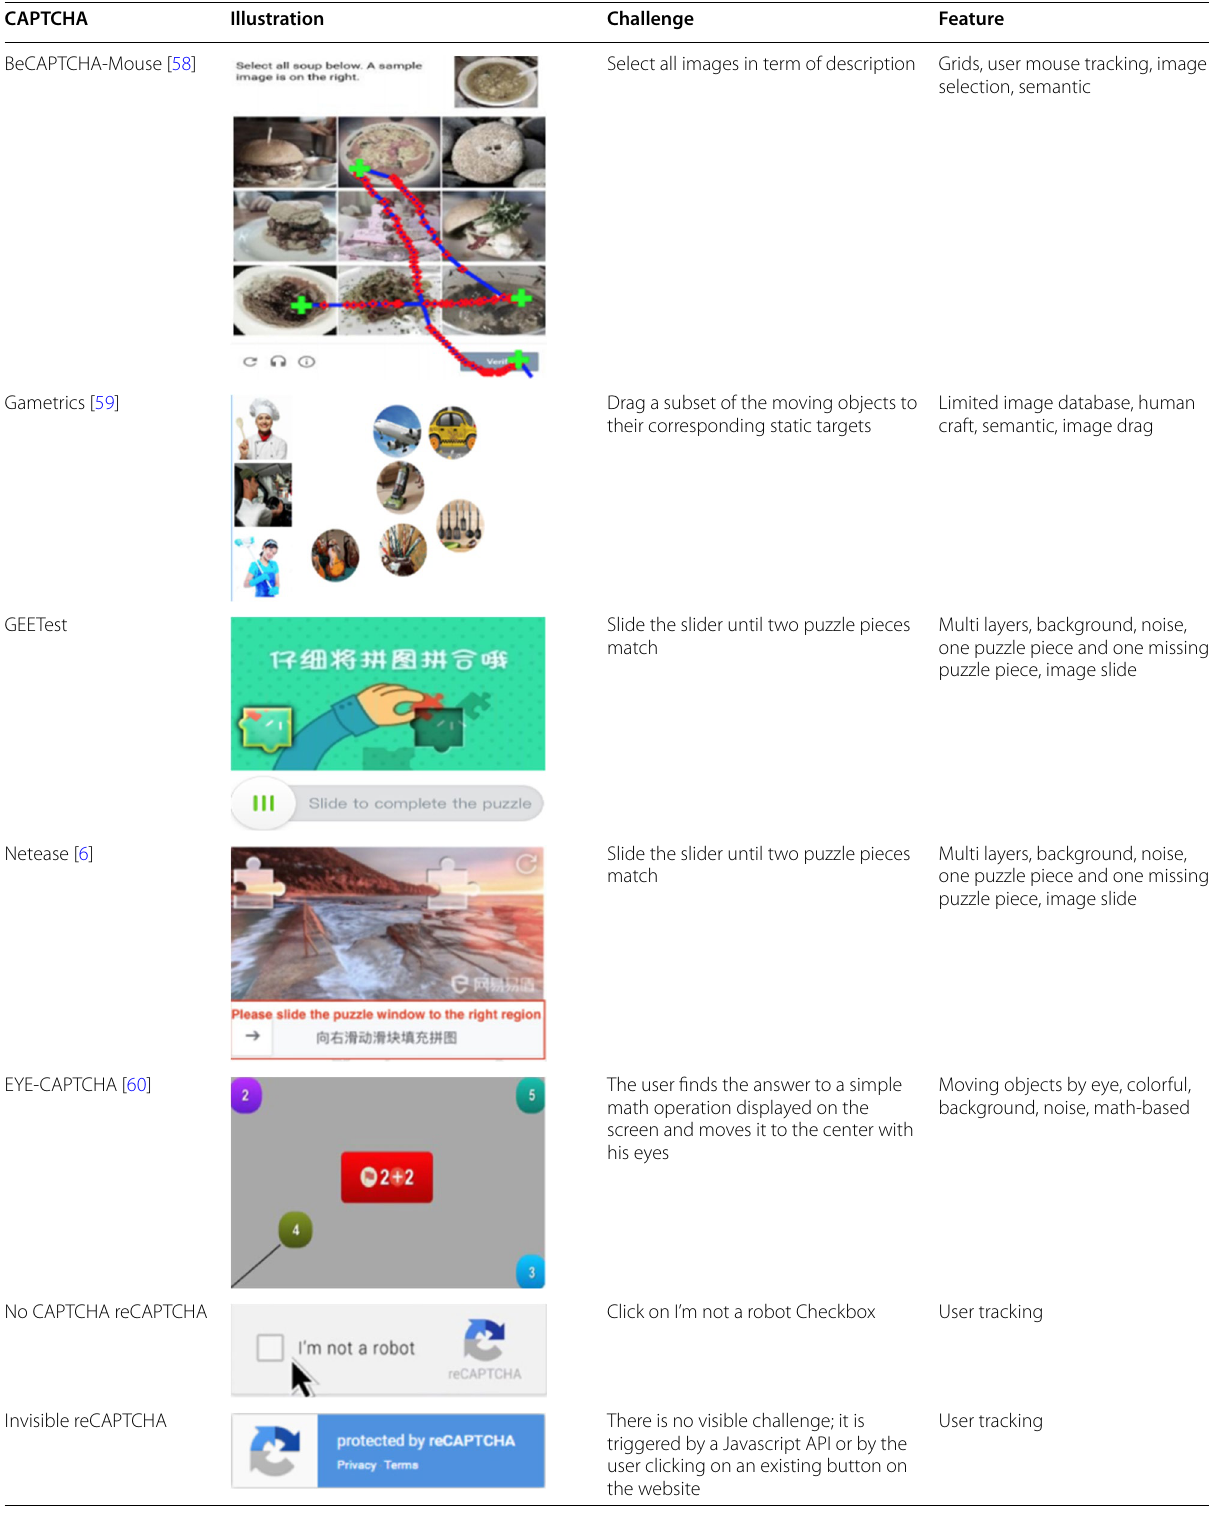
Table 5 Typical cognitive-based CAPTCHAs